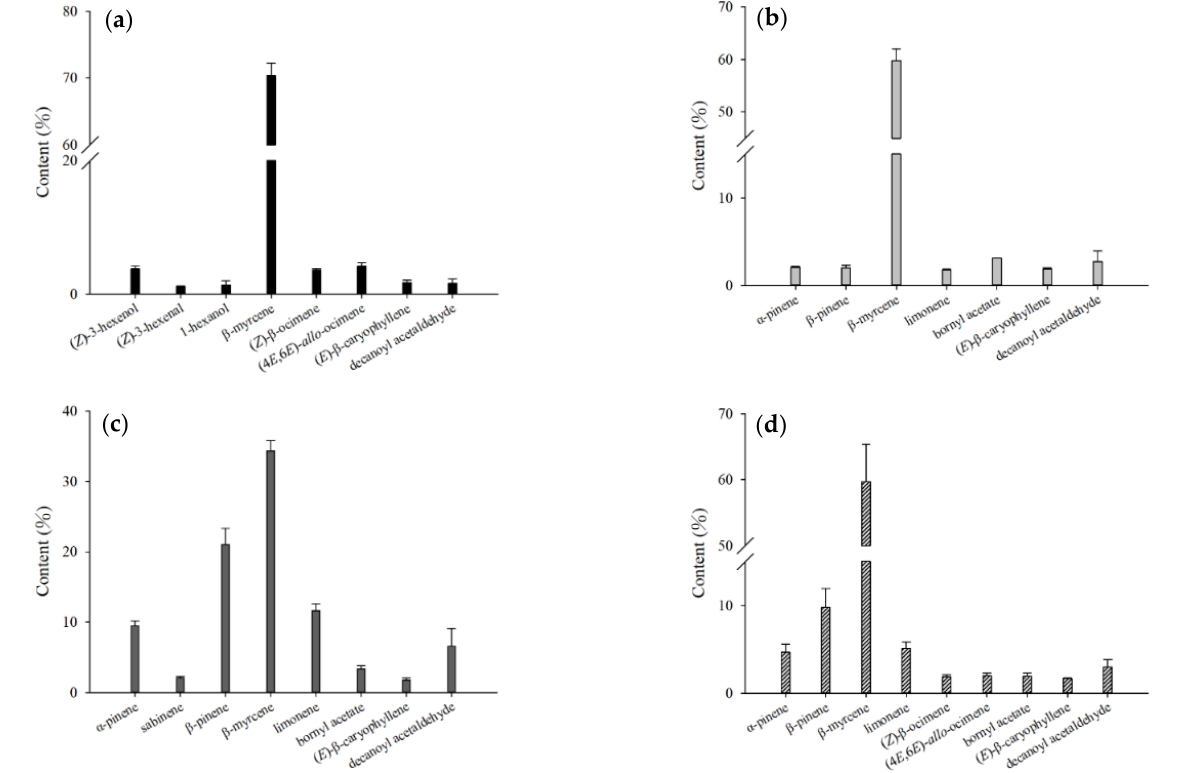
Figure 4. Comparison of the contents of the major volatile compounds from different parts of fresh H. cordata analyzed by HS-SPME: ( a ) leaf; ( b ) stem; ( c ) rhizome; and ( d ) whole plant.